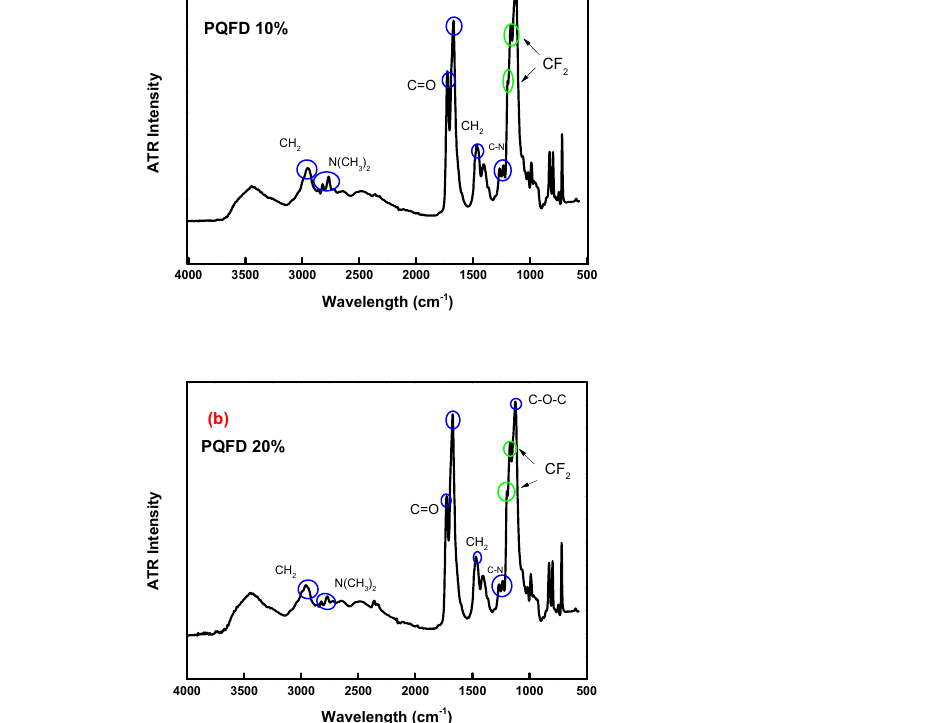
Figure 3. ATR − FTIR spectra of the ( a ) quaternized PQFD 10% copolymer and ( b ) quaternized PQFD 20% copolymer.